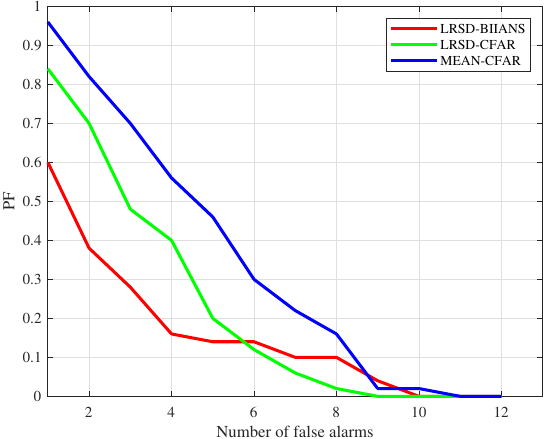
Figure 11. Comparison of false alarms suppression of different methods.